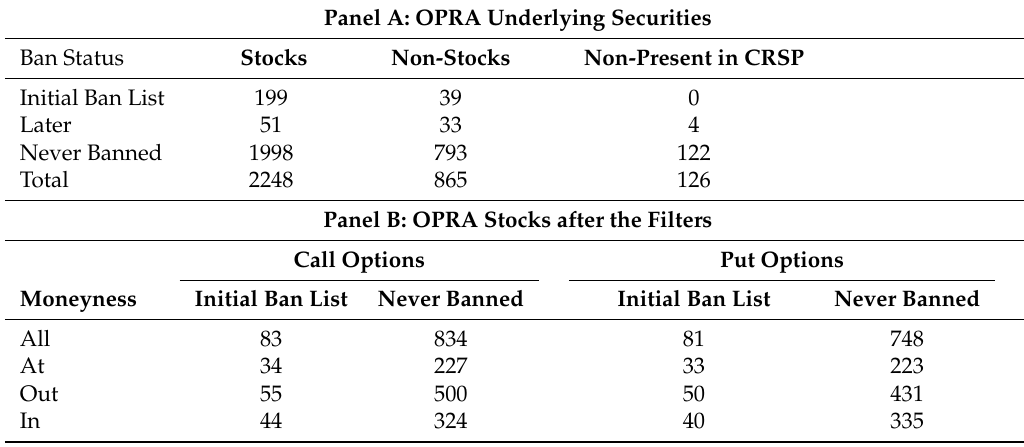
Table 1. OPRA underlying stocks and short sales ban status. Panel A: OPRA Underlying